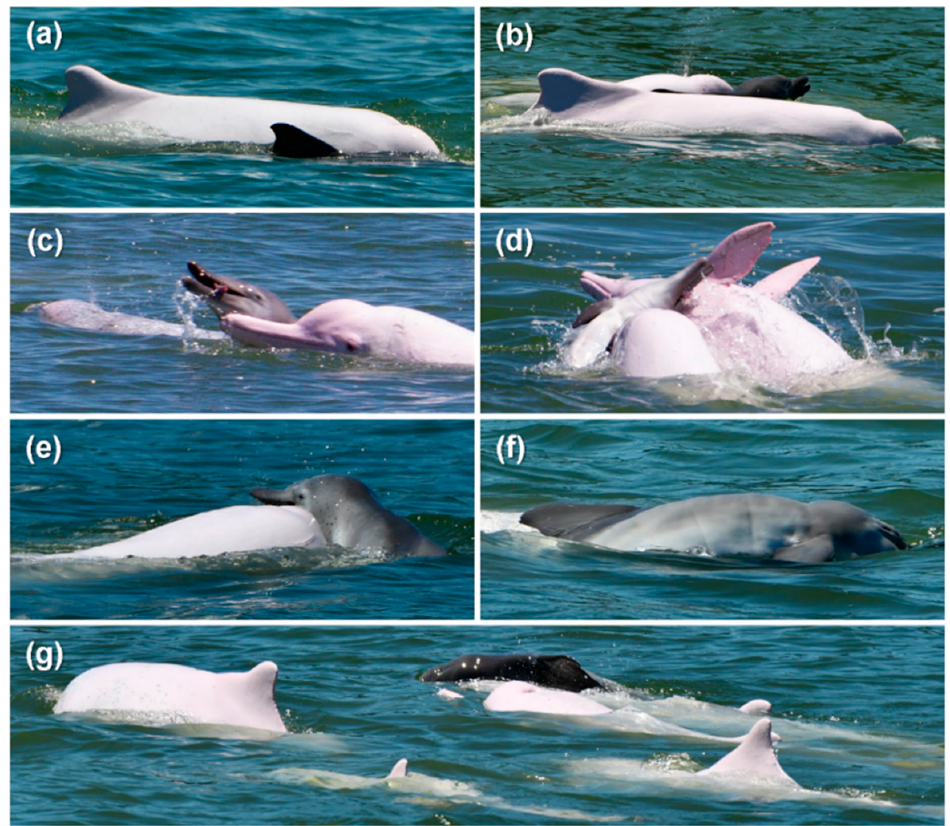
Figure 2. Vessel-based photographs of the group of Indo-Pacific humpback dolphins Sousa chinensis taken from the research vessel. ( a ) The neonate positioned adjacent to the presumed mother in an echelon position; ( b ) the neonate supported by the presumed mother and an escort; ( c – e ) the neonate in a flaccid state with tilted head and protruding tongue lifted by the presumed mother and escorts; ( f ) the presence of fetal folds on the neonate; ( g ) multiple conspecifics escorting the pair (neonate and presumed mother) in a synchronous raft-like formation.